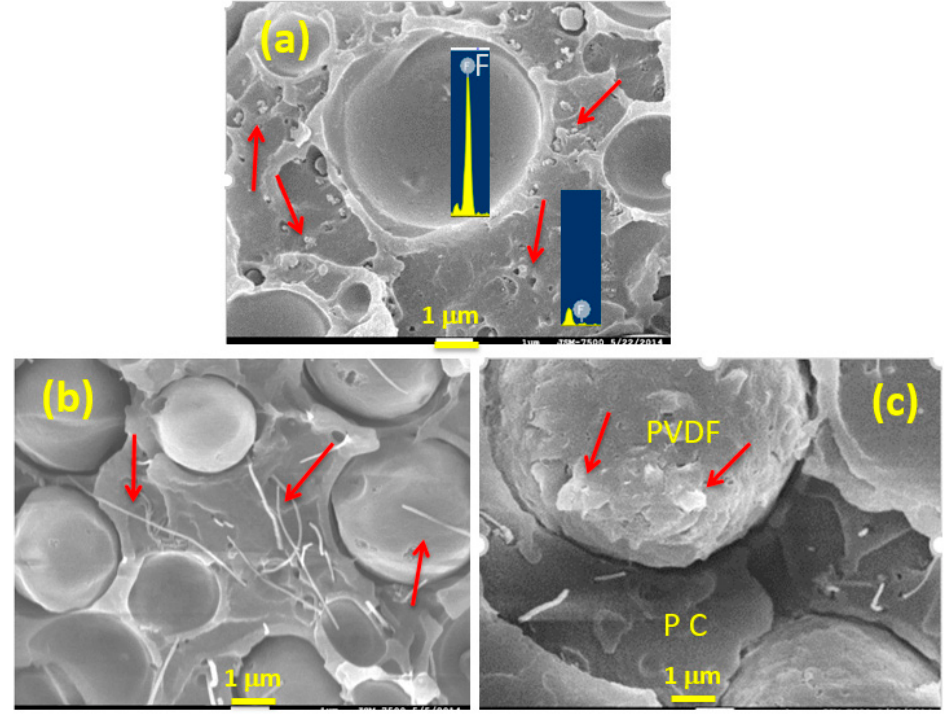
Figure 2. Higher-magnification SEM images of: ( a ) CF-B (with EDS data), ( b ) CF-T, and ( c ) CF- TA.